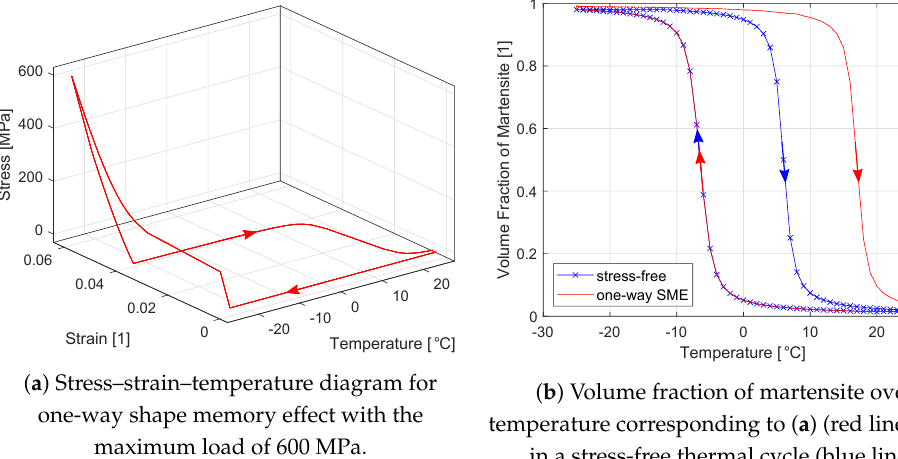
Figure 3. One-way shape memory effect (Example